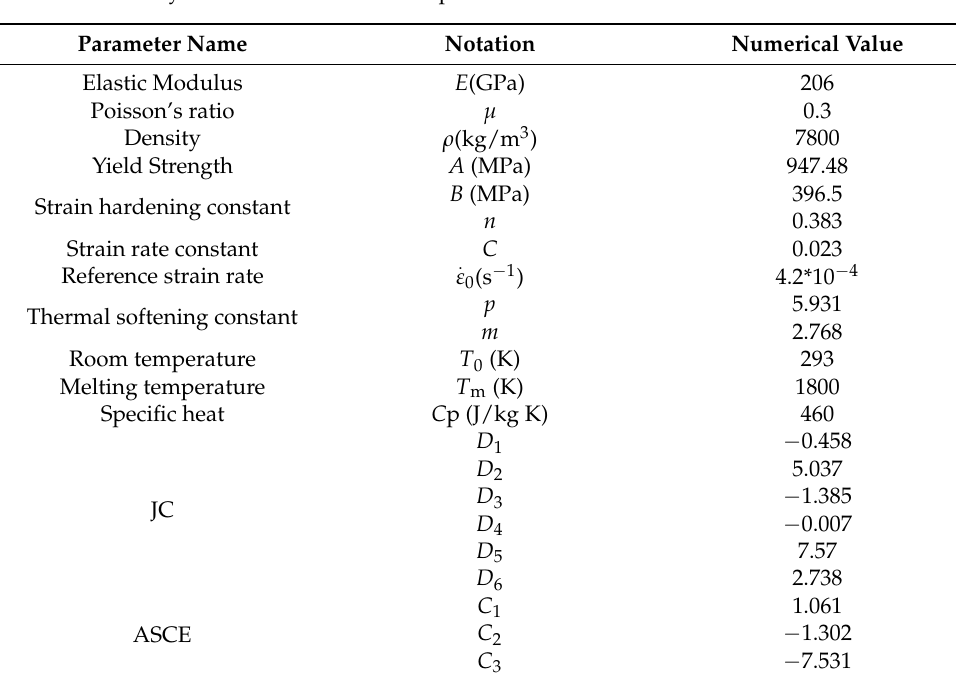
Figure 7. Fracture strain at different strain rates. Table 3. Summary of Weldox 900 E material parameters.